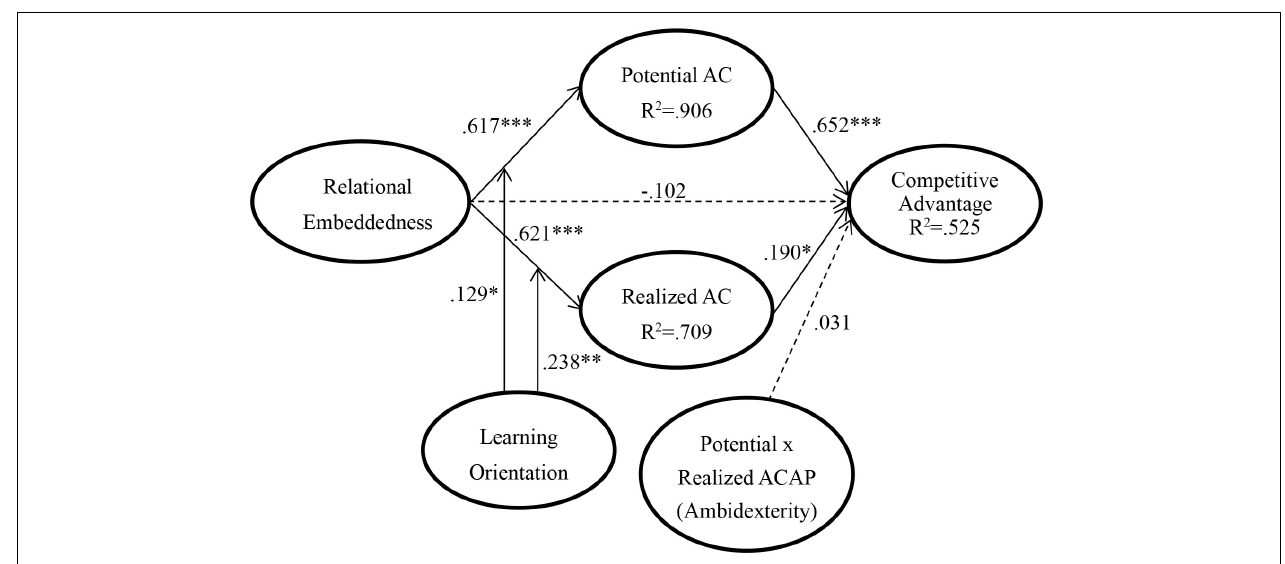
FIGURE 2 | PLSSEM